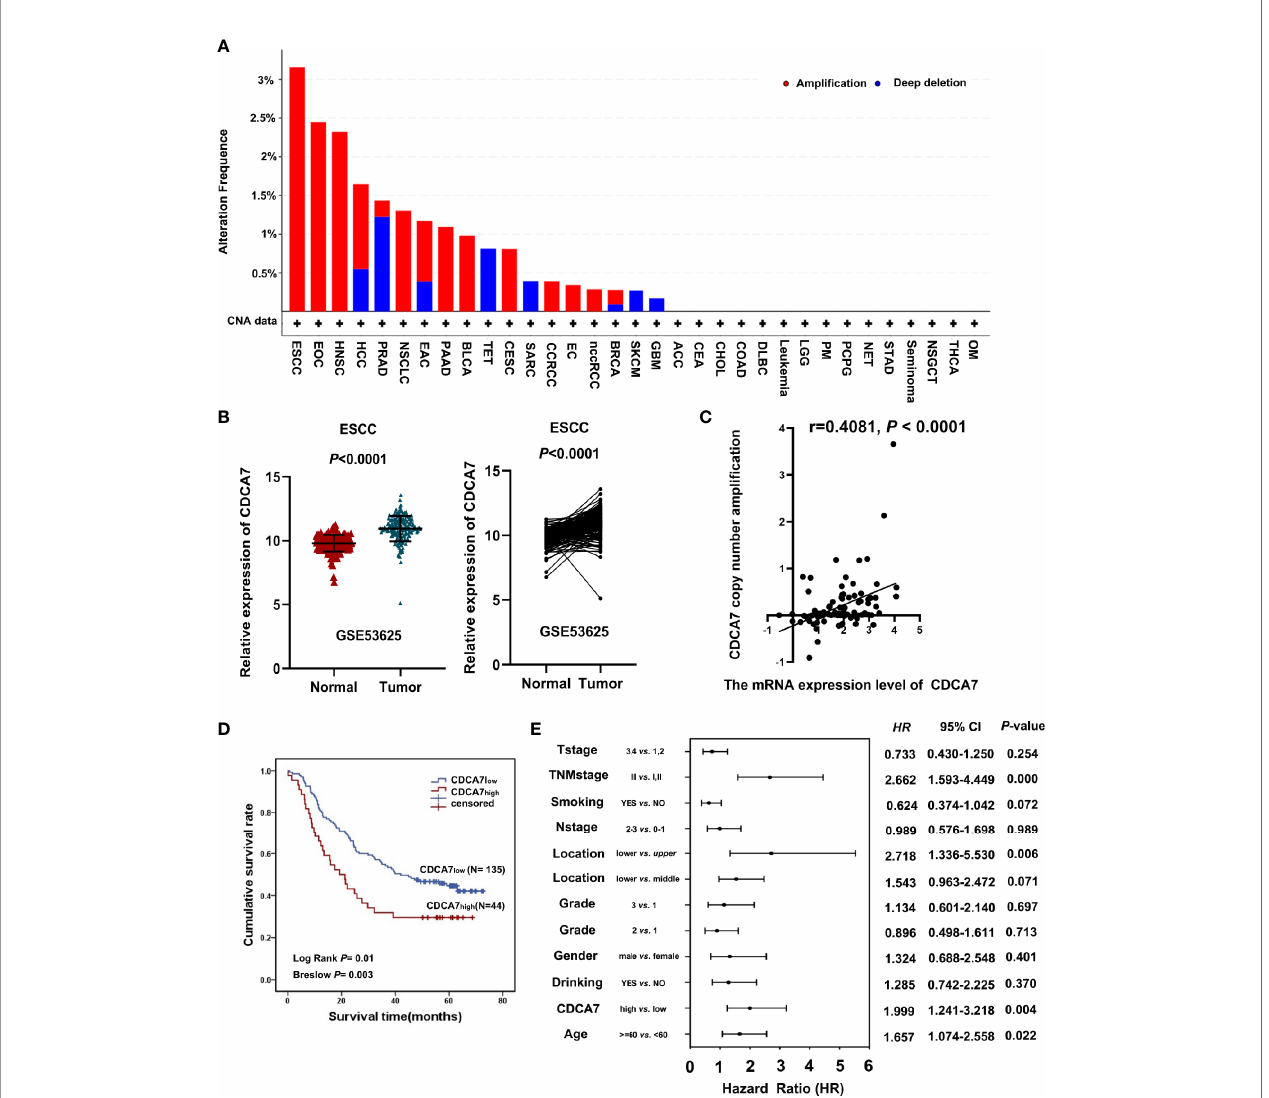
FIGURE 1 | CDCA7 expression predicts the prognosis of esophageal squamous cell carcinoma (ESCC) patients. (A) The CDCA7 copy number ampli fi cation of various kinds of tumor in the TCGA database. (B) ESCC tumor tissues had a high CDCA7 expression compared with its non-tumor tissues using non-paired t -test and paired t -test; P < 0.001. (C) The correlation analysis between CDCA7 copy number ampli fi cation and expression ( r = 0.4081, P < 0.0001). (D) The patients with CDCA7 low had better survival than those with CDCA7 high (log rank P = 0.01) using Kaplan – Meier survival analysis. (E) Multivariate analysis showed that TNM stage [hazard ratio (HR) = 2.662, 95% CI: 1.593 – 4.449, P < 0.001), location (lower vs. upper) (HR = 2.718, 95% CI: 1.336 – 5.530, P = 0.006), age (HR = 1.657, 95% CI: 1.074 – 2.558, P = 0.022), and CDCA7 expression were independent predictive factors for overall survival (HR = 1.999, 95% CI: 1.241 – 3.218, P =